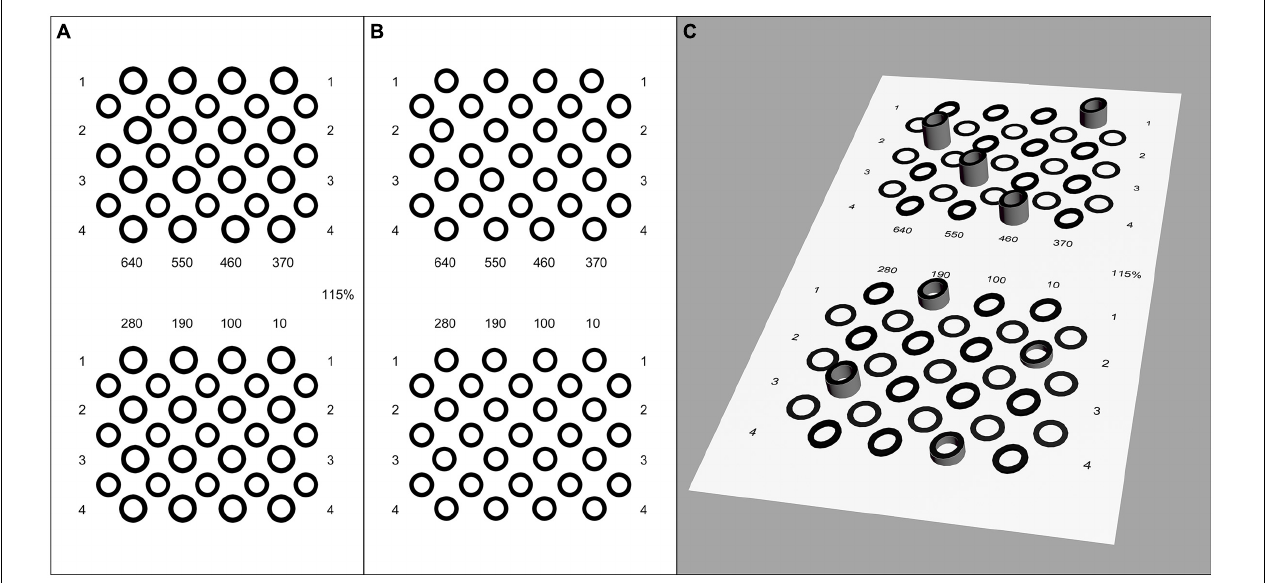
FIGURE 3 | Legend of contour-based pattern of the first grade test page with 15% induced overall aniseikonia. (A) Left eye image. (B) Right eye image. (C) Simulation of the perception of the test images. The disparity of the target circle was 640 (cid:48)(cid:48) , 550 (cid:48)(cid:48) , 460 (cid:48)(cid:48) , 370 (cid:48)(cid:48) , 280 (cid:48)(cid:48) , 190 (cid:48)(cid:48) , 100 (cid:48)(cid:48) , and 10 (cid:48)(cid:48) . The center of the comparison circles was at the same point when fused correctly, but the size of test symbols in left eye image was enlarged by 15% because of the induced aniseikonia. All test circles appeared to be rotated at a certain angle clockwise along the vertical axis of the screen.